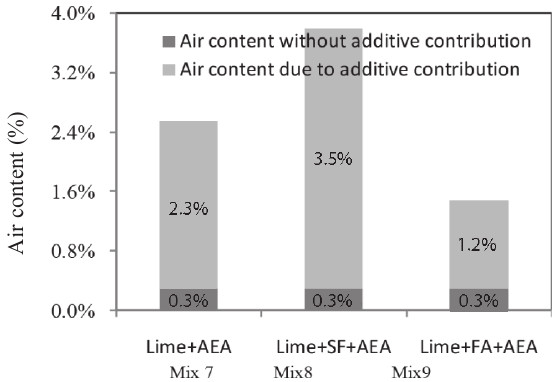
Fig. 7. SEM image of 7-days hardened grout with SP (mix 4) at 5000x